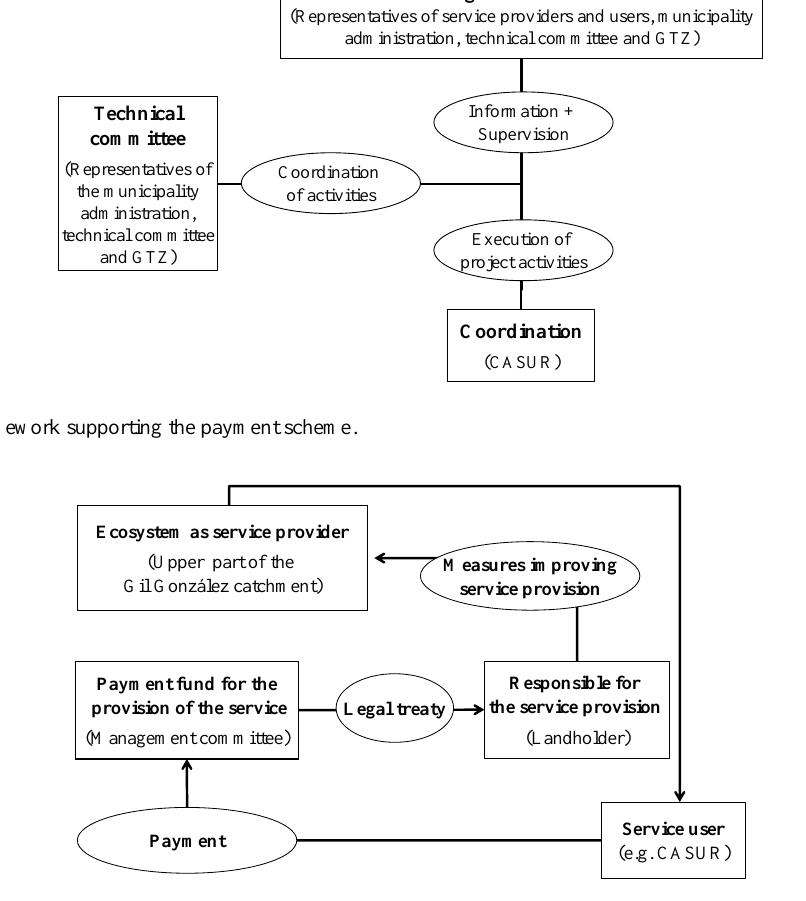
Fig. 3. Payment scheme of the Gil Gonz´alez